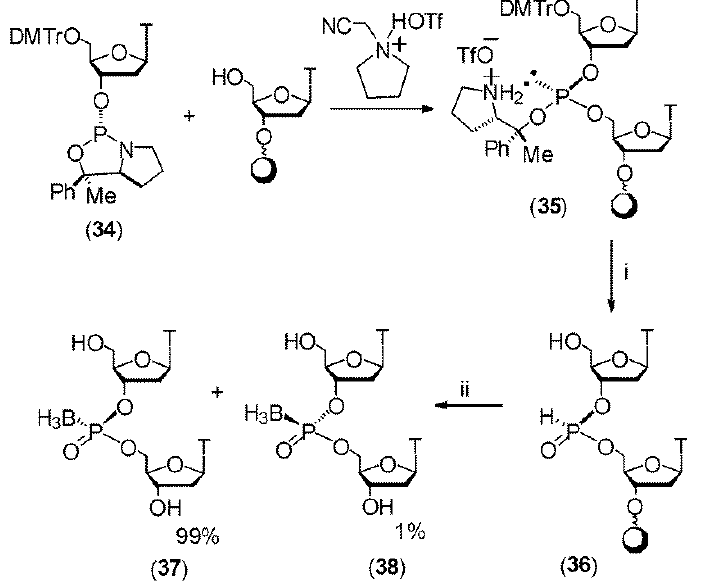
Scheme 8. Synthesis of stereodefined boranephosphonate linked